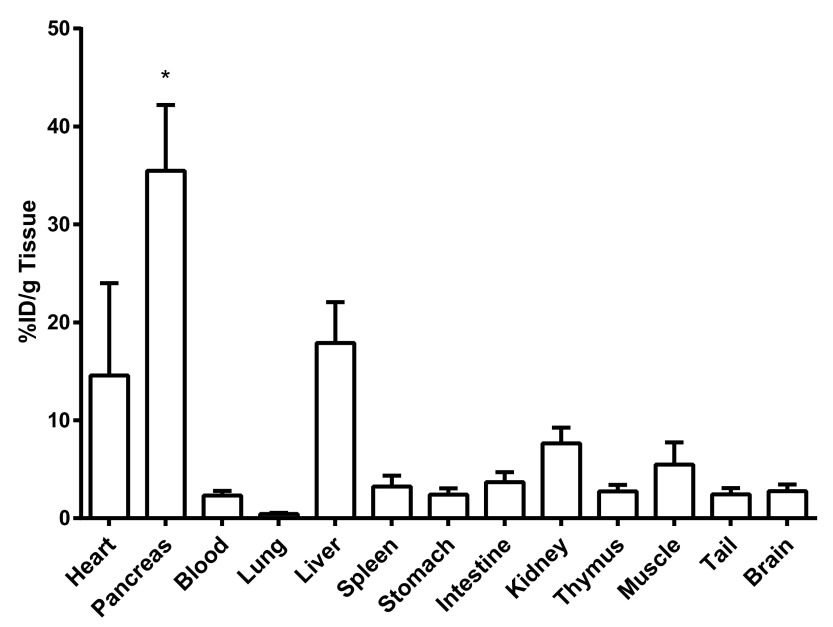
Uptake of
18F-L-FEHTP in wt mice.
Ex vivo biodistribution was calculated for the indicated organs as % injected dose/g tissue (%ID/g tissue) at 1.5 h after injection. Values are given as mean ± SEM (n=6). * p< 0.05 compared to all other organs except heart and liver.